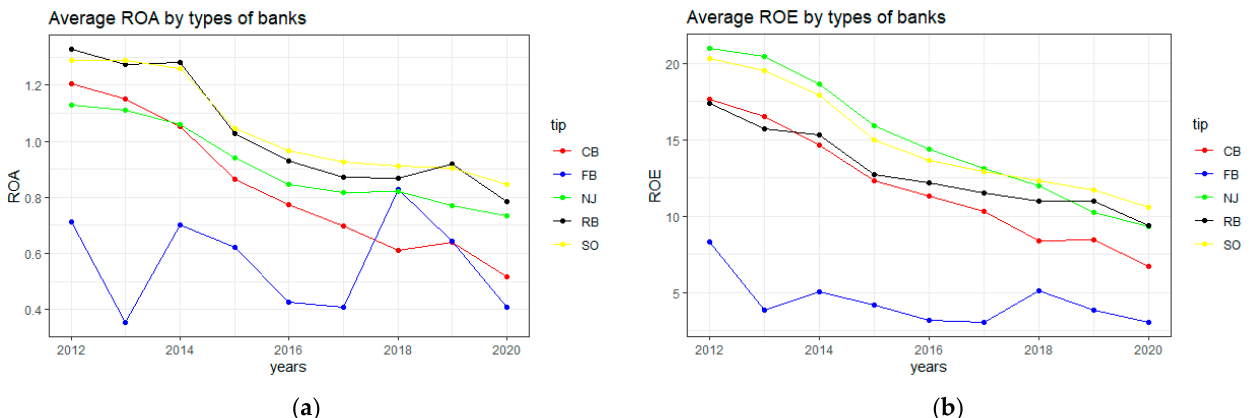
Figure 2. ( a ) Average return on assets by bank type; ( b ) average return on equity by bank type. Source: author’s preparation. Notes: (left) axis of ordinates − average return on assets for a group of banks; abscissa axis − years; (right) axis of ordinates − average return on equity for a group of banks; abscissa axis − years; categories − groups of banks, state commercial banks (SO), national joint stock commercial banks (NJ), foreign commercial banks (FB), rural commercial banks (RB), urban com- mercial banks (CB).